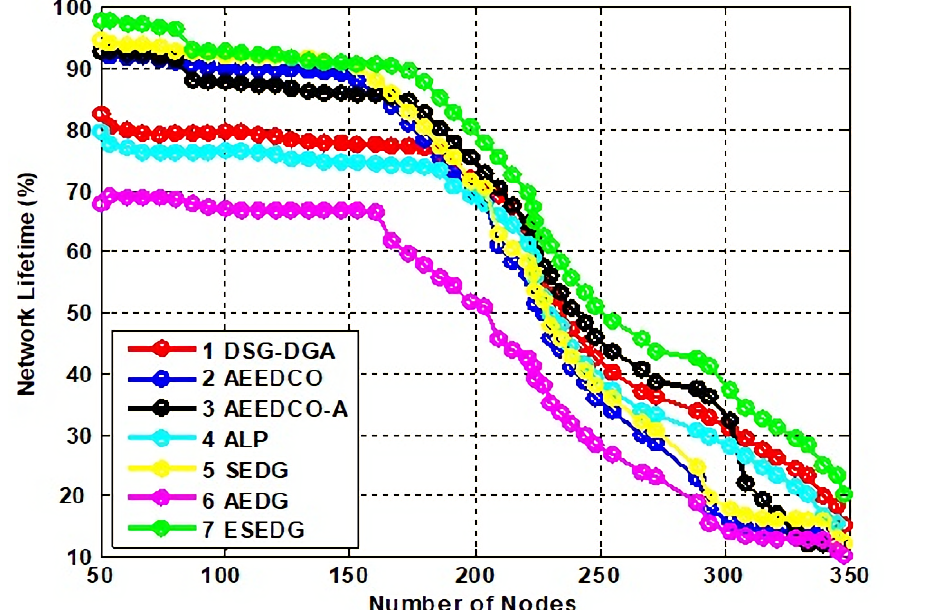
Figure 9. Analysis of network lifetime loss with baseline